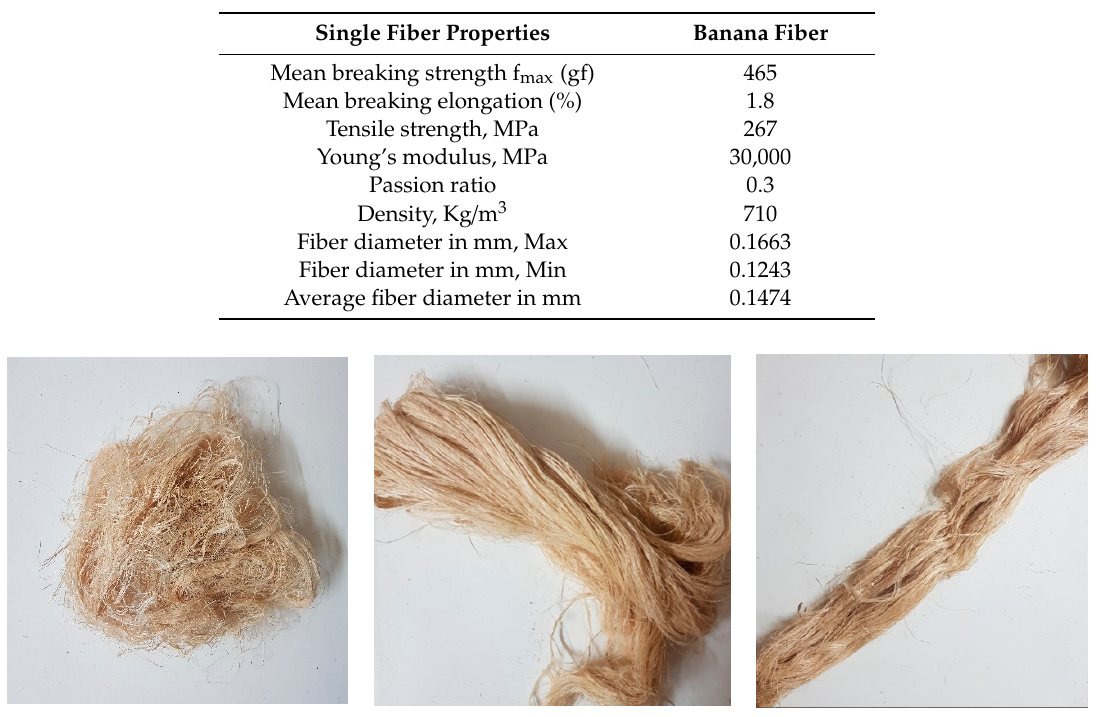
Table 1. Mechanical properties of banana fibers.